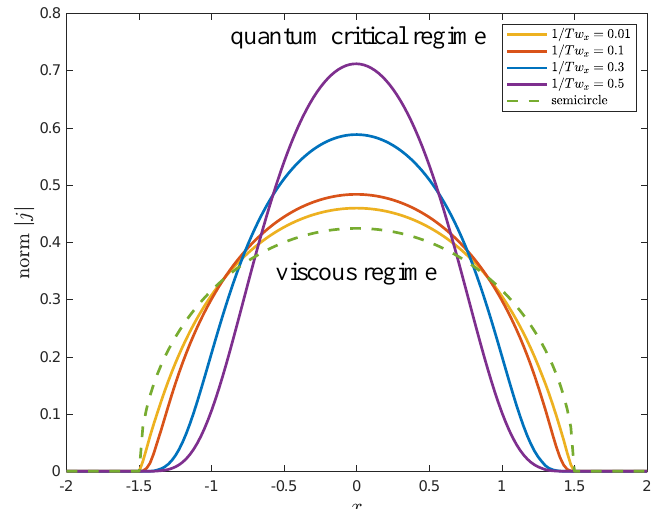
Figure 3: Simulated examples of current flow distribution at finite density ( Q = 0.5, as defined in the appendices) through a slit of w The distribution evolves from semi-circular in the viscous regime to sinusoidal in the quantum critical